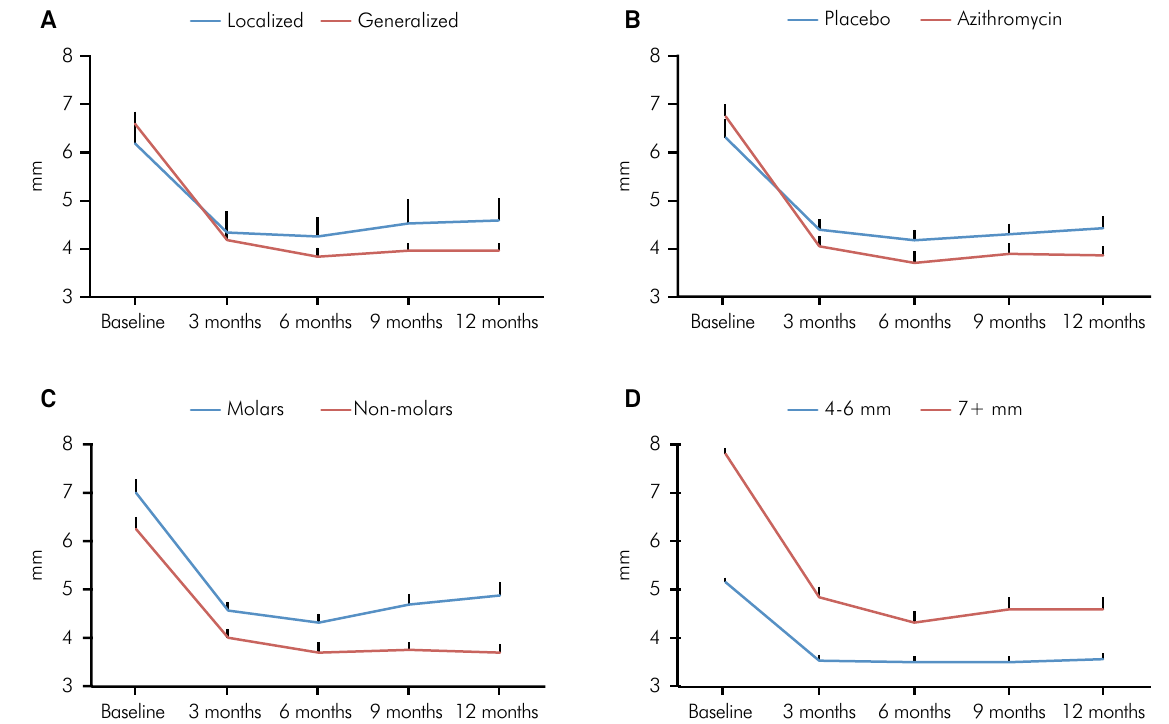
Figure 2. Periodontal probing depth over 12 months, according to different predictors (a: disease extent; b: antibiotic use; c: tooth type; d: baseline